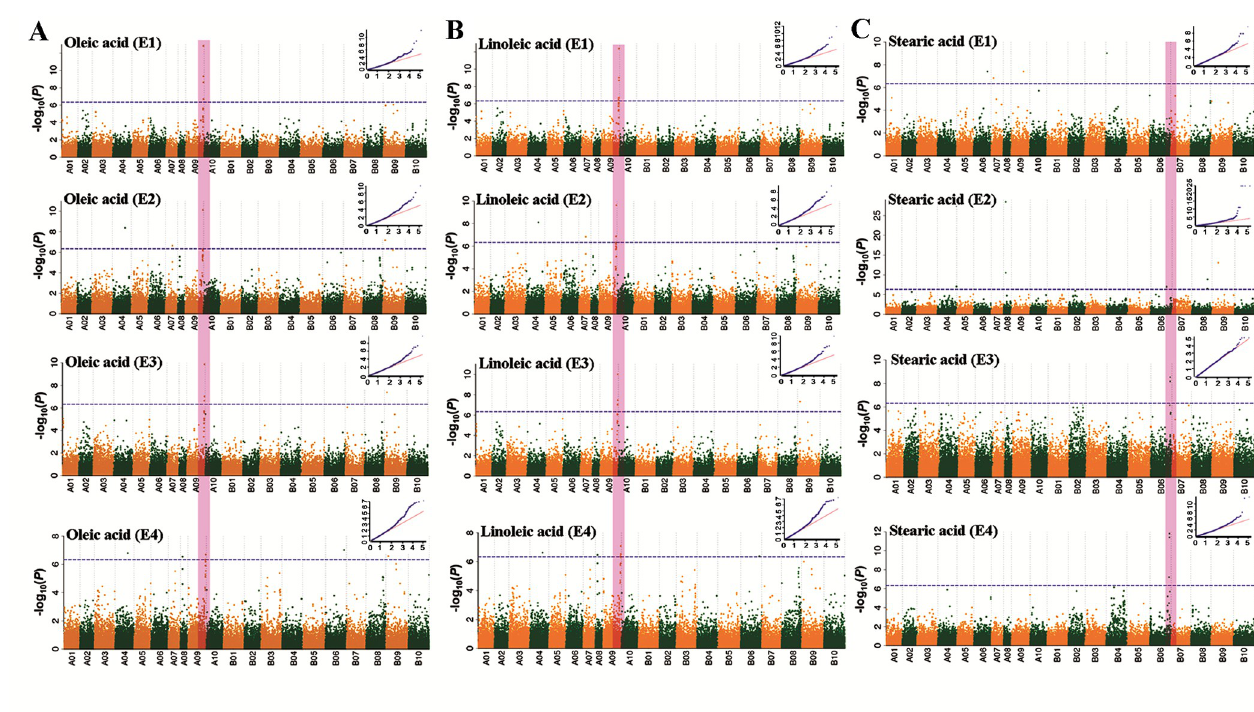
Fig 2. GWAS association loci for oleic acid, linoleic acid and stearic acid in the Chinese peanut mini-core collection under four environments. (A) Manhattan plots and quantile-quantile plots for oleic acid (C18:1). Negative log 10 ( P ) values from a genome-wide scan are plotted against position on each of twenty chromosomes. The horizontal dashed lines indicate the genome-wide significance threshold (-log 10 4.73 × 10 − 7 = 6.33). (B) Manhattan plots and quantile- quantile plots for linoleic acid (C18:2). (C) Manhattan plots and quantile-quantile plots for stearic acid (C18:0). The horizontal coordinates of quantile-quantile plots represented expected -log 10 ( P ), and the vertical coordinates of quantile-quantile plots represented observed -log 10 ( P ).